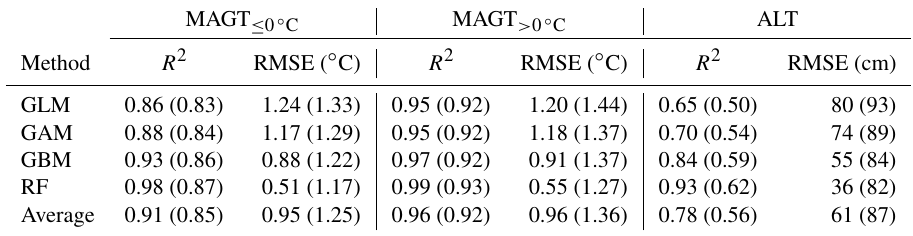
Table 1. Adjusted coefficient of determination ( R 2 ) and root-mean-square error (RMSE) between observed and predicted mean annual ground temperature (MAGT) and active-layer thickness (ALT) in calibration and evaluation (in brackets) datasets averaged over 100 permu- tations. MAGT ≤ 0 ◦ C MAGT > 0 ◦ C